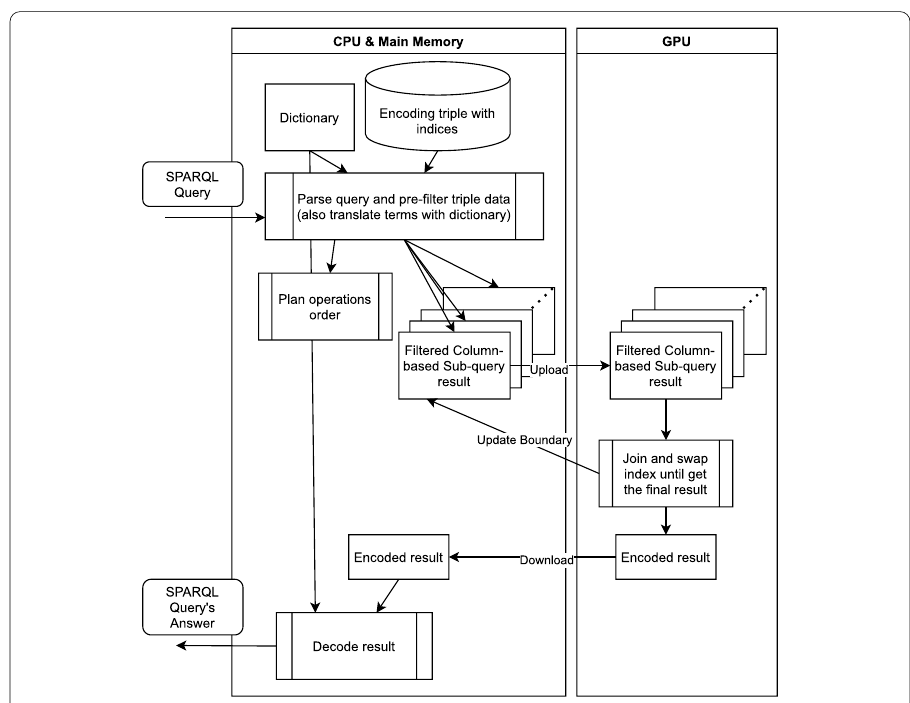
Fig. 11 VEDAS’s activity diagram to process the SPARQL